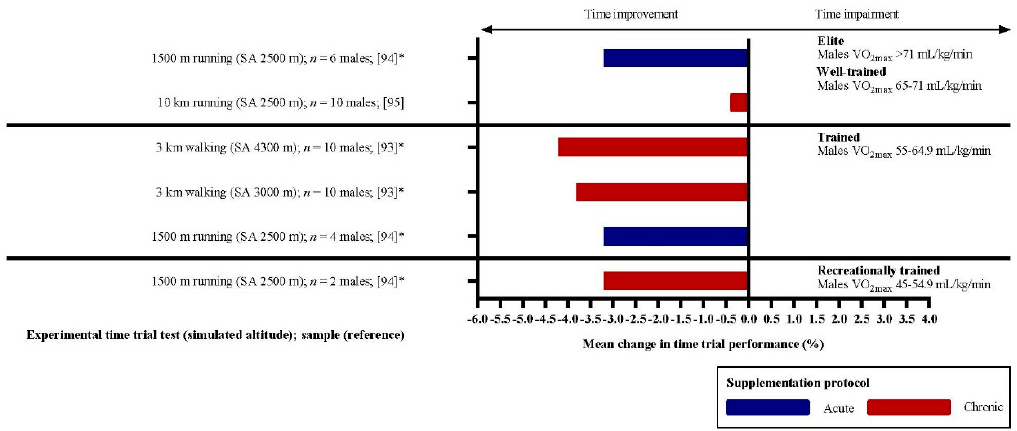
Figure 5. Training status and ergogenicity in simulated high-altitude. Cited studies are listed in References [93–95]. * Statistically significant improvement in performance following DN supplementation.